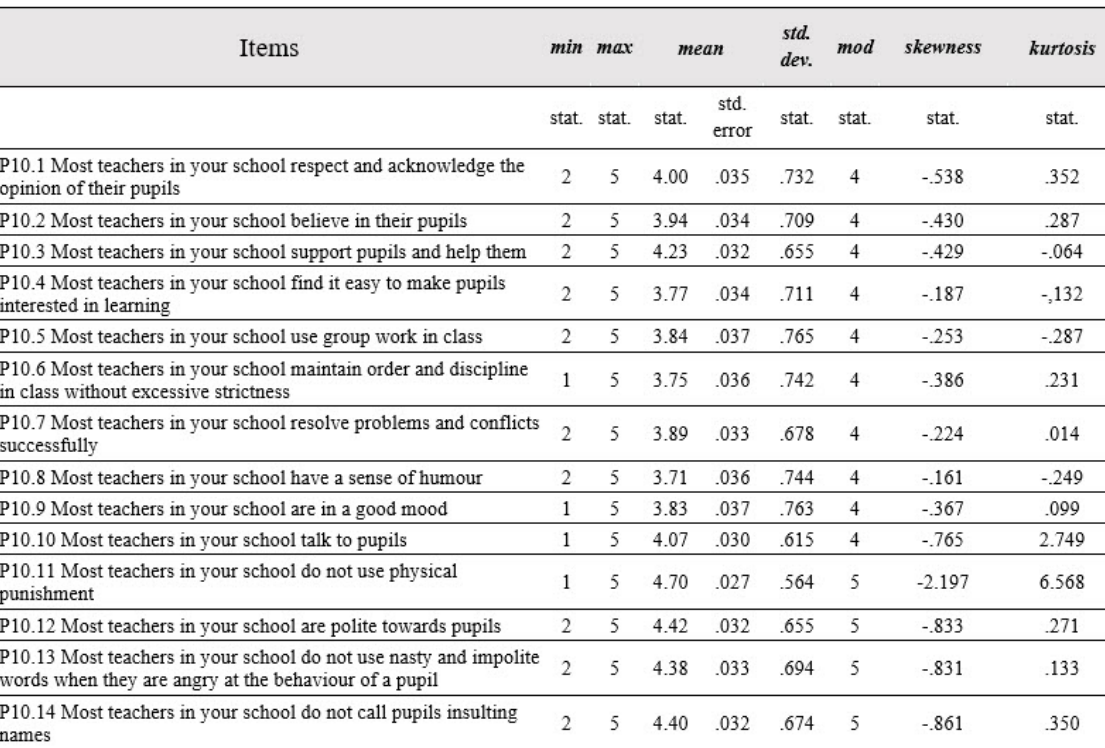
Table 3. Main descriptive values of the